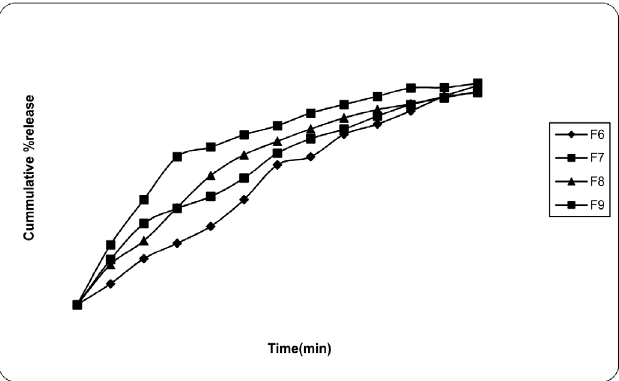
FIGURE 5 - Comparative results of in vitro release profile of different proportions of SA, CH, and SCMC beads of sodium diclofenacin phosphate buffer pH 7.4.